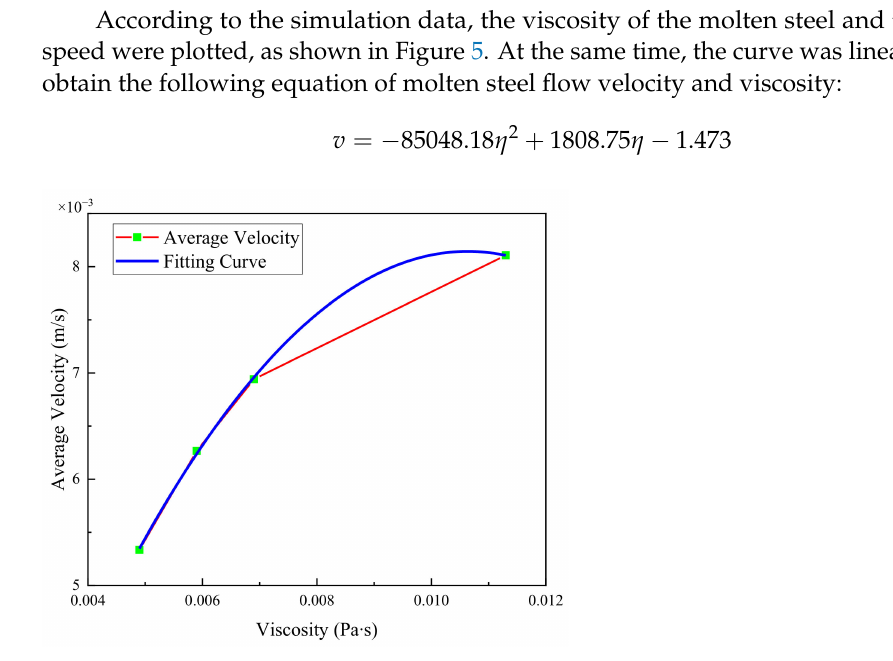
Figure 5. Average velocity versus molten steel viscosity diagram and fitting